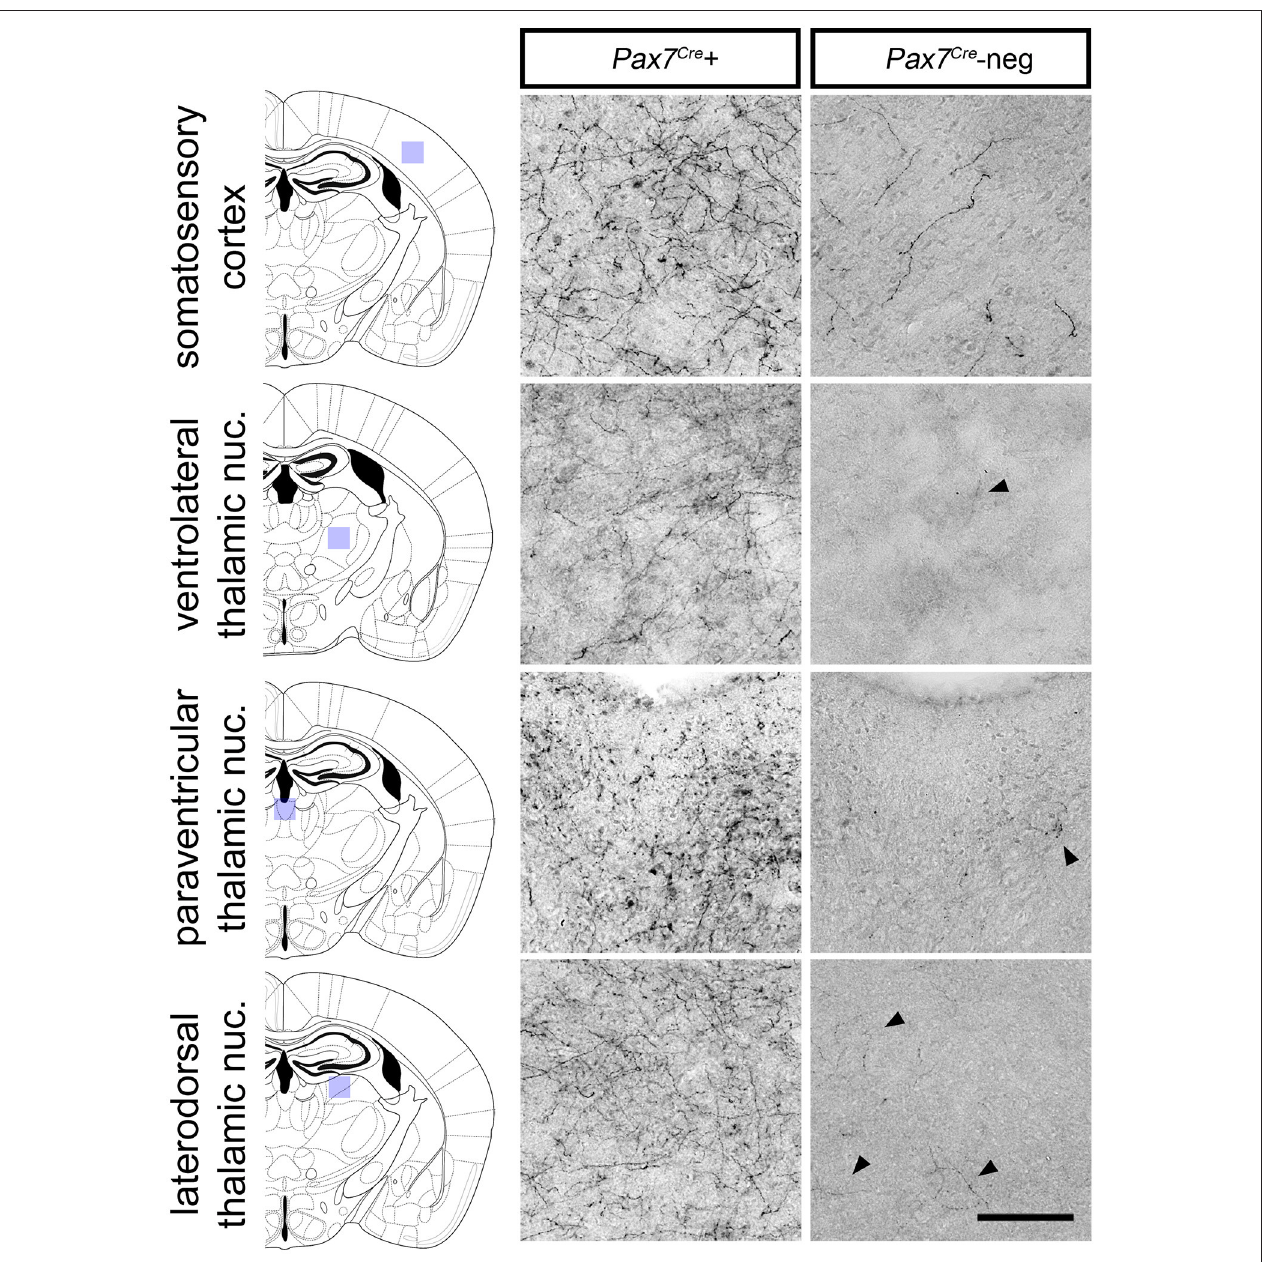
FIGURE 6 | Axonal projections of Pax7 Cre -negative and Pax7 Cre -positive LC complex noradrenergic neurons. In representative coronal sections from the brain of a 3-month old adult En1 Dre ; Dbh Flpo ; Pax7 Cre ; RC::RFLTG quadruple heterozygote, dense innervation by axons of Pax7 Cre -positive (EGFP-labeled) neurons in the LC complex is observed in cortex and thalamus. Axons from the smaller Pax7 Cre -negative (tdTomato-labeled) subpopulation are consistently observed in cortex, but they are very sparse in thalamus. Black arrowheads indicate occasional tdTomato-labeled axons in representative sections from thalamic nuclei. Scale bar: 100 µ